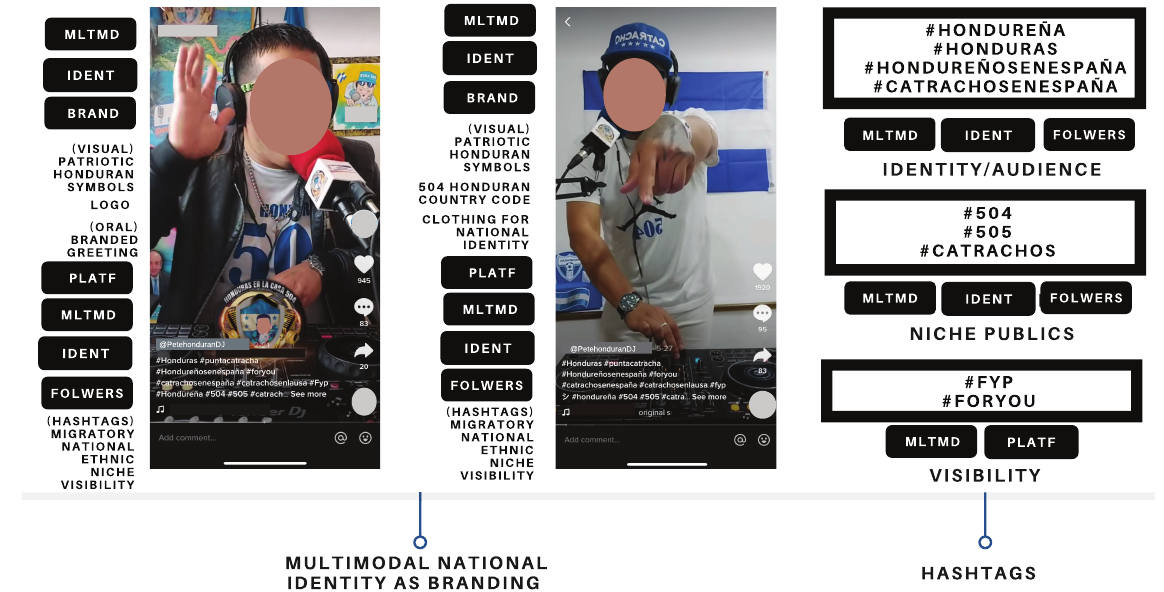
Figure 8. PeteHonduranDJ’s multimodal branding and hashtag